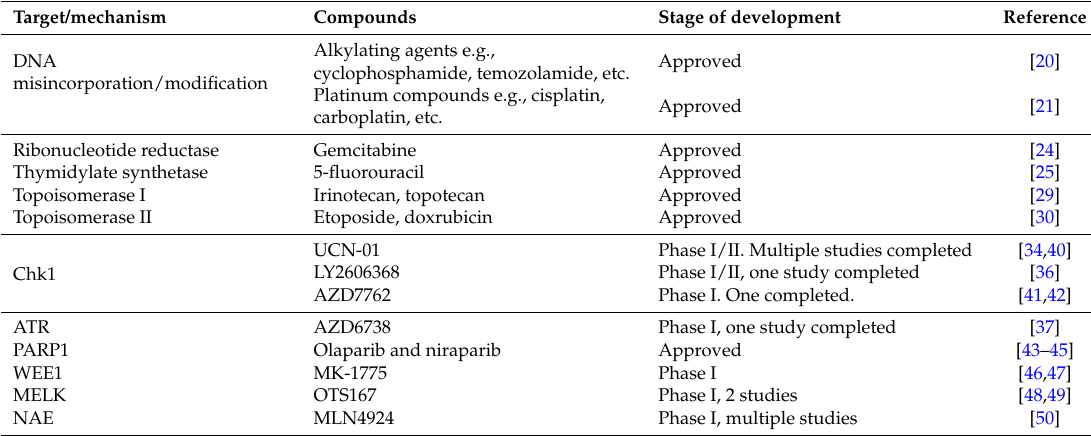
Table 1. Therapeutic agents that enhance replicative